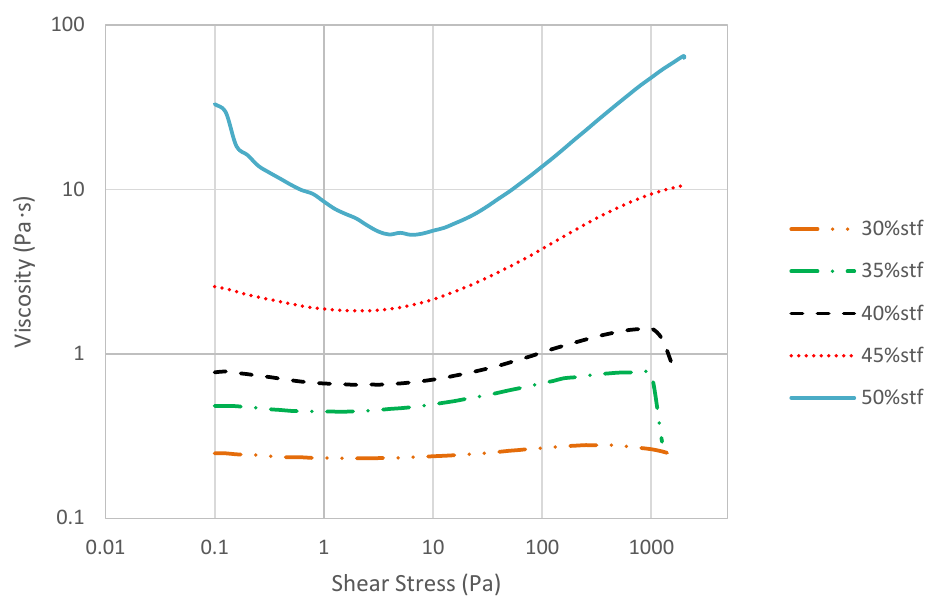
Figure 4. Shear stress effect on viscosity at 25 °C.